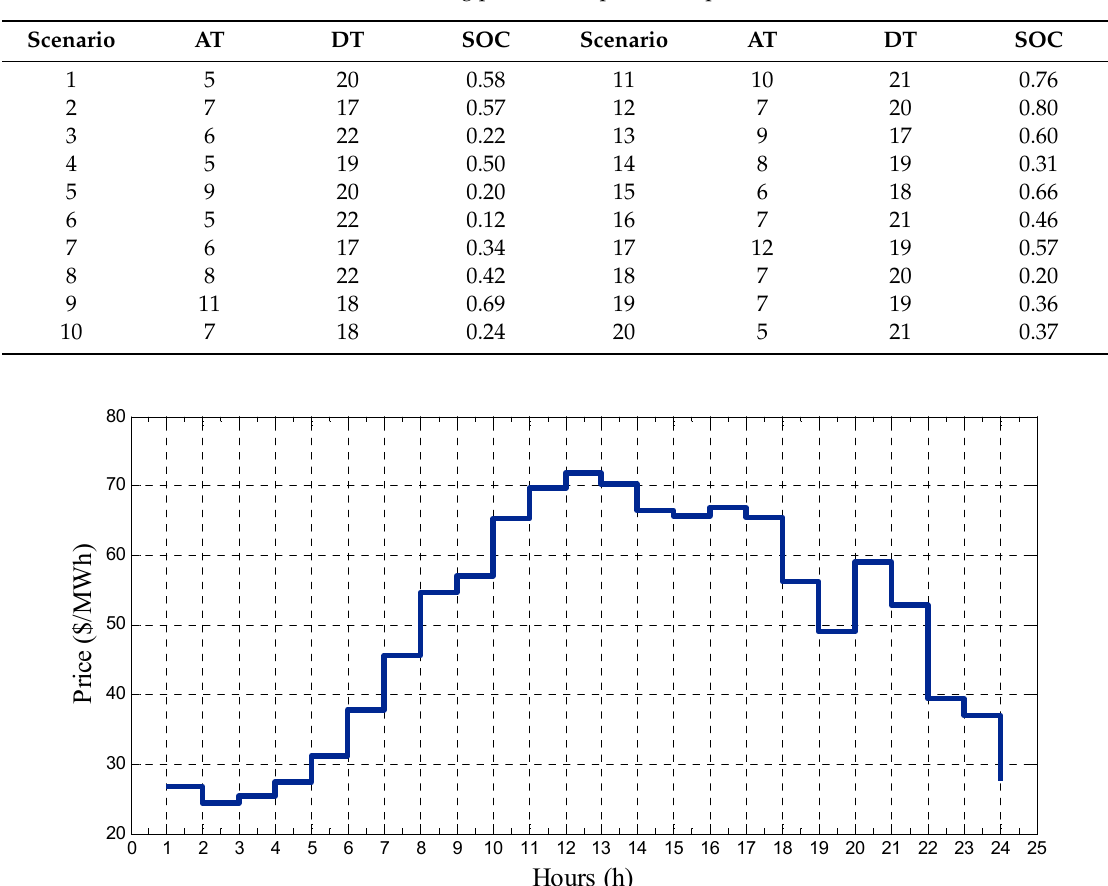
Table 3. Final scenarios of EV driving patterns. Reprint with permission [31]; 2018, Elsevier.